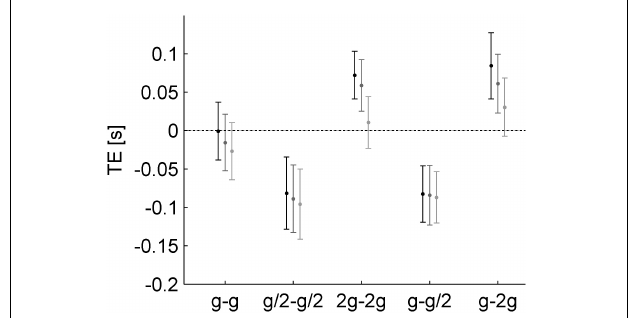
FIGURE 7 | Timing errors for each gravity condition and traveled distance on the incline (mean ± 95% confidence interval, two visual conditions × sixteen subjects, n = 32). Different gray levels denote different traveled distances as in Figure 6